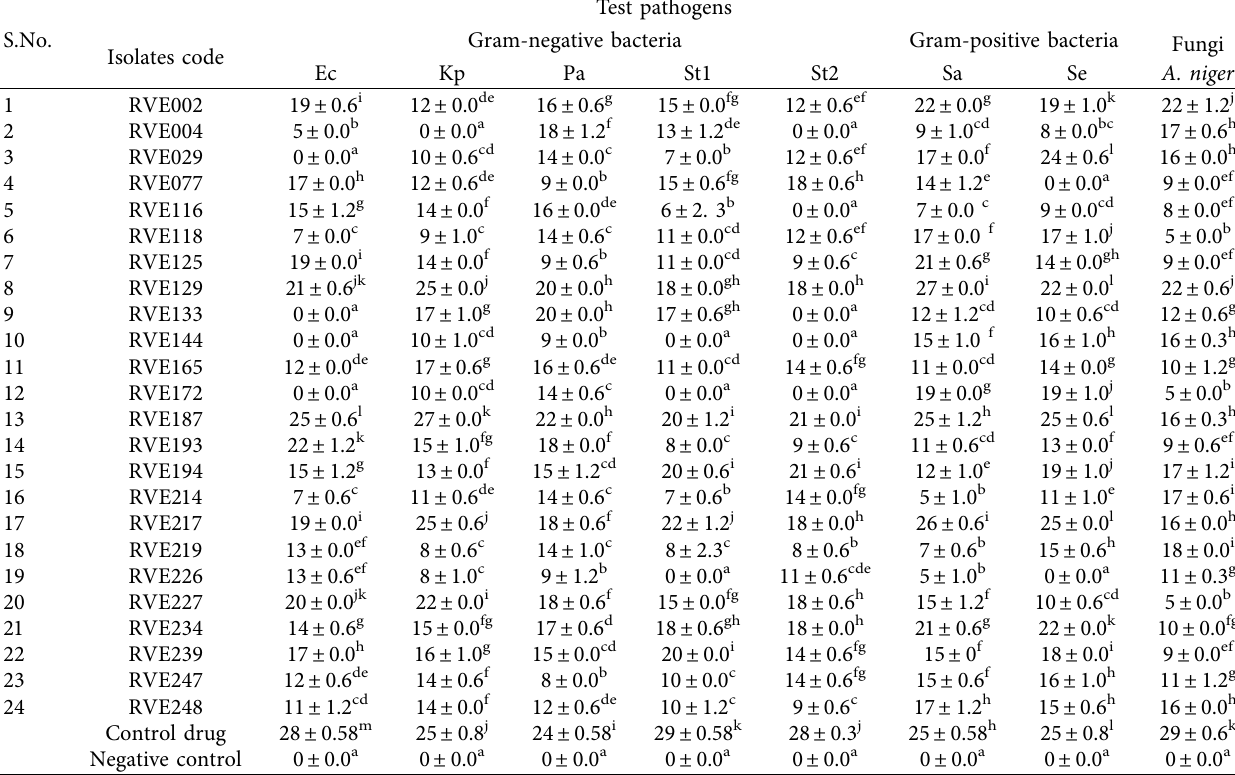
Table 3: The antimicrobial activity (mm) of the isolates against bacterial pathogens during secondary screening.